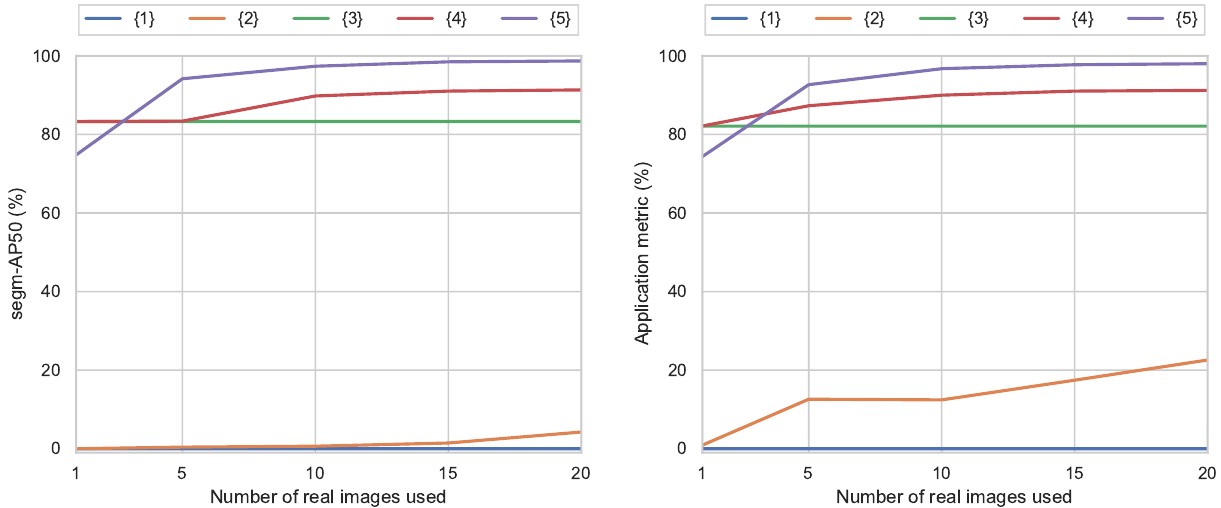
Figure 9. Overall results of the different tests with segm-AP50 and application metrics. Analyzing the errors of the proposed system in more detail, most of the not detected errors are on bricks that are touching each other on the image and for which it is difficult to discern one from the other, specifically when they are of the same color and their boundaries are not clearly distinguishable. Most of the misclassified errors are between bricks that are almost identical from a certain point of view or have the same shape but can have different lengths; even for a human annotator, these are difficult to differentiate without using other bricks in the image to have a sense of scale between